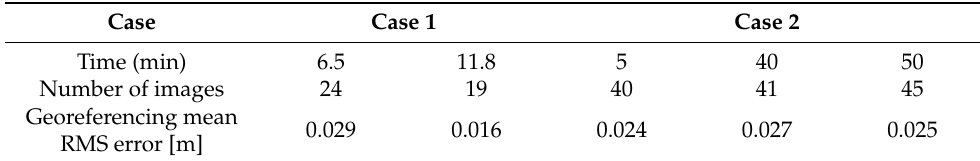
Table 2. Number of images used in 3D modeling and positional accuracy evaluation results.